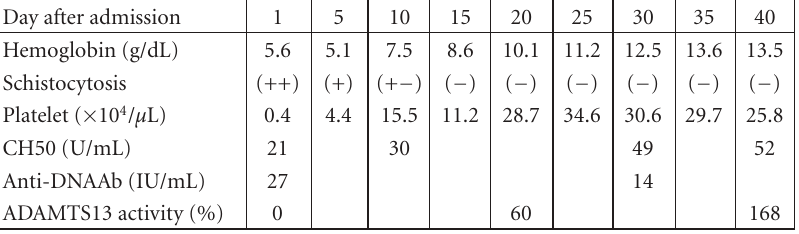
Figure 1: The clinical course in the present case. The patient was treated with intravenous administration with methylprednisolone (1000mg/day for 3 days on the admission) followed by oral administration with prednisolone (50mg/day). Daily plasma exchange and anticoagulant therapy was added on the second day. Plasma exchange was performed for 5 consecutive days and stopped at the sixth day of the admission. Subsequently, peripheral schistocytes diminished, her hemoglobin level and platelet count were improved, the complement level increased, the titer of anti-DNA antibody decreased, and the ADAMTS-13 activity increased. mPSL: methylprednisolone, and PSL: